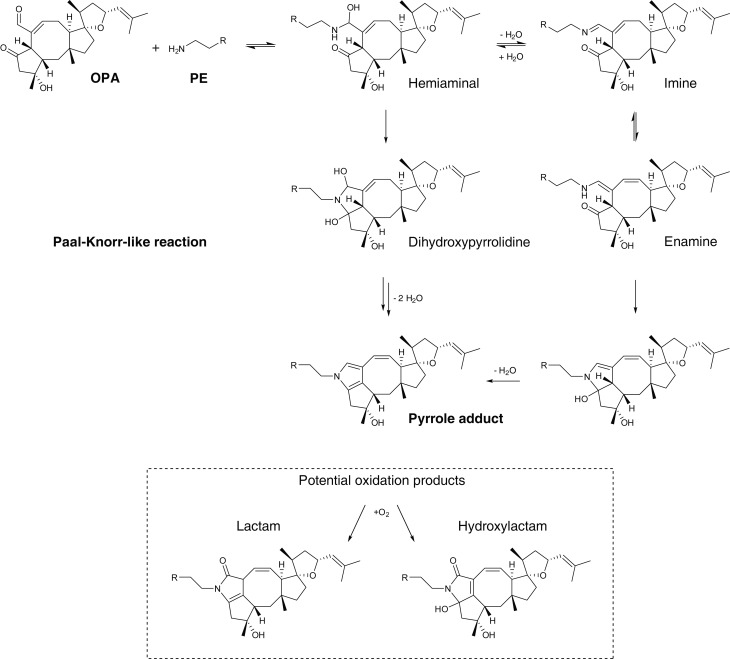
Proposed mechanism of covalent modification of phosphatidylethanolamine (PE) by ophiobolin A (OPA) through a Paal-Knorr-like reaction pathway (Bernoud-Hubac et al., 2004; Amarnath et al., 1991, 1995).Addition of the amino group of PE onto the aldehyde moiety of OPA leads to formation of a hemiaminal. Based on the mechanism of the Paal-Knorr reaction and the specific reactivity of OPA, the reaction between PE and OPA is believed to proceed through two potential mechanisms: (i) elimination of a water molecule leading to formation of an imine and subsequent rearrangement to an enamine. Cyclization of the enamine followed by dehydration yields the final pyrrole-containing adduct. (ii) Cyclization of the hemiaminal leads to formation of a dihydroxypyrrolidine. A double elimination of water and double bond shift leads to the final pyrrole-containing adduct. In studies involving the formation of pyrrole adducts from the reaction of 4-oxohexanal and a primary amine, the reaction is known to proceed through the mechanism involving cyclization of the hemiaminal (Amarnath et al., 1995). Under certain conditions, pyrrole adducts are known to be oxidized and the two main expected products are the lactam and hydroxylactam derivatives (Sullivan et al., 2010). In addition, OPA contains an unsaturated aldehyde moiety which is known to readily react with thiols in a Michael addition reaction (Grimsrud et al., 2008). 4-Oxo-2-nonenal, a product of cellular lipid oxidation which has similar reactive functionalities as OPA, has been shown to readily react with N-acetylcysteine (Amarnath and Amarnath, 2015). Interestingly, initial Michael adduct formation of OPA with a thiol would not prevent a subsequent Paal-Knorr reaction with PE and furthermore these two sequential reactions could lead to protein-lipid crosslinking, a potential cause of cytotoxicity.